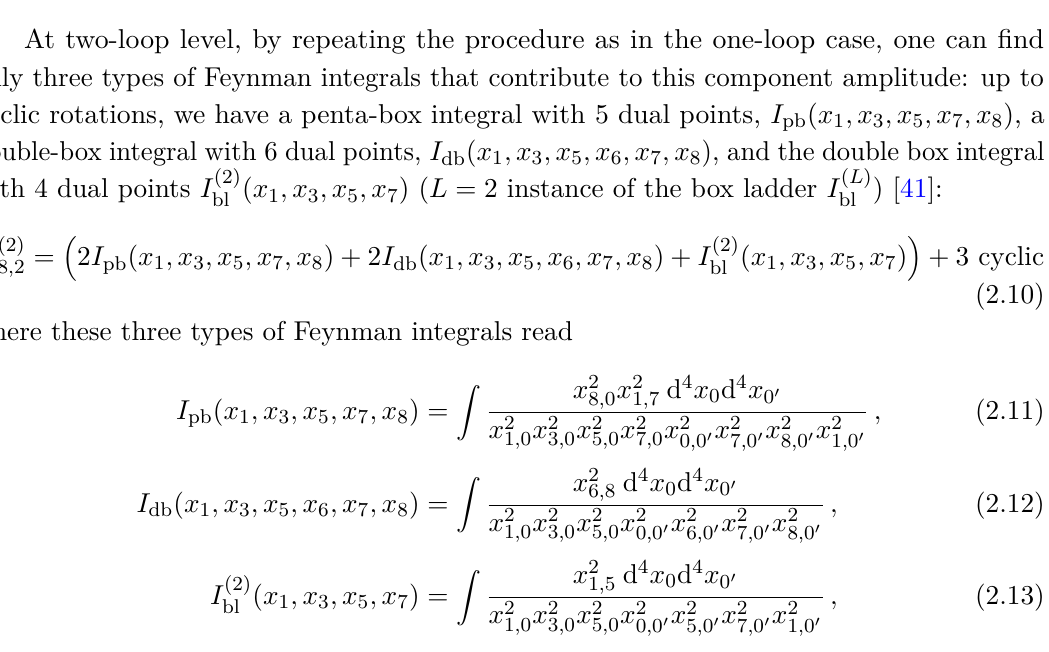
Figure 1 . Three Feynman diagrams as well as their dual diagrams that contribute to the two-loop N 2 MHV component amplitude A (2) : the penta-box diagram, the double-box diagram, and the box- 8 , 2 ladder diagram. In the dual diagrams, the line connecting to two dual points, x a factor x 2 in the denominator, while the dotted line represents a factor in the numerator. a,b where the box integral has been denoted as the one-loop instance of well-known